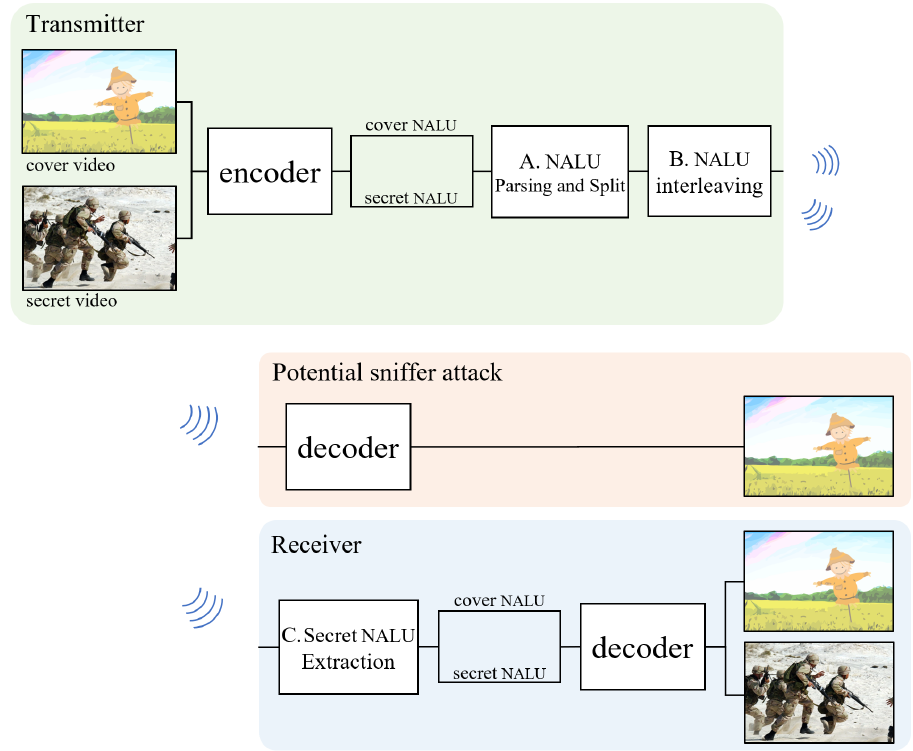
Figure 2. The block flow diagram of the proposed deception